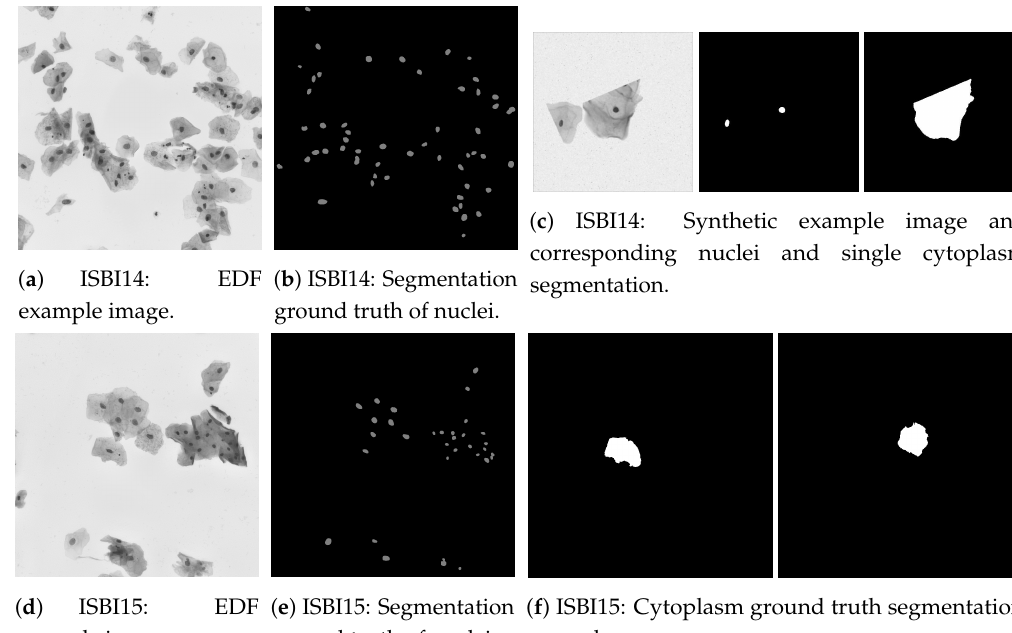
Figure 5. Sample images and corresponding segmentation masks of ISBI14 and ISBI15